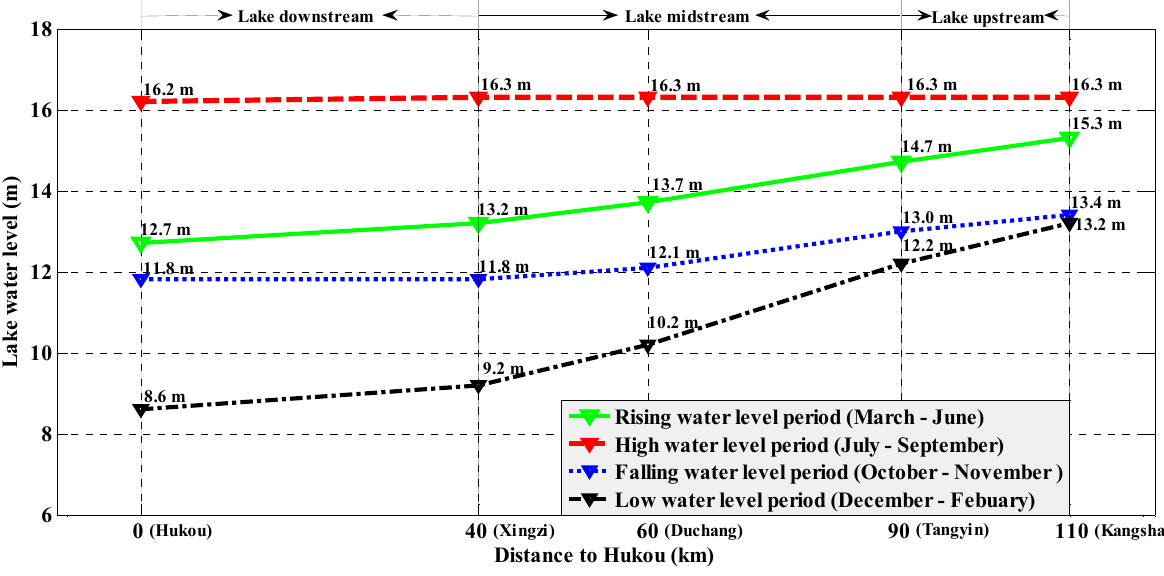
Figure 2. Observed lake water surface profiles for different water level periods based on the average water levels of the Hukou, Xingzi, Duchang, Tangyin and Kangshan gauging stations for the years